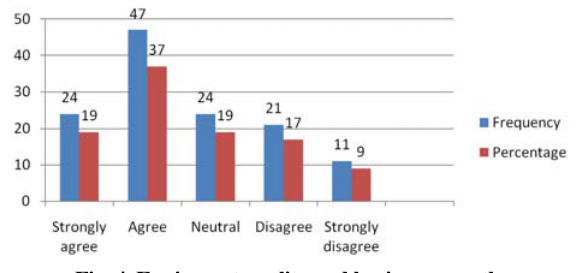
Fig. 4. Equipment quality and business growth